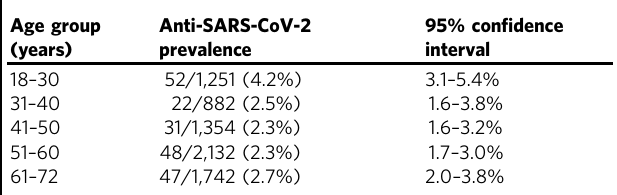
Table 1 Prevalence of anti-SARS-CoV-2 antibodies in Dutch blood plasma donors ( n = 7,361) by age group; 1 – 15